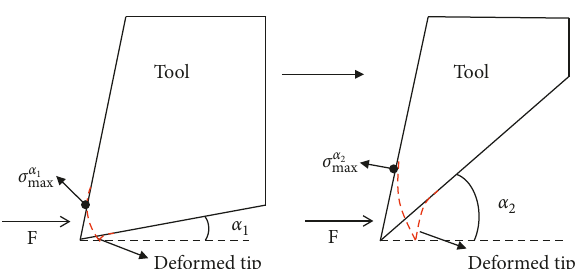
Figure 16: Schematic of deformation and stress on the rack face under different tool back angles.